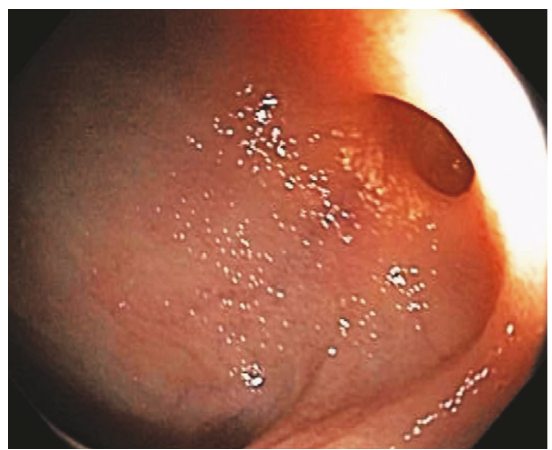
Figure 12: Endoscopic image of an uncommon ileal diverticulum (right upper corner) in the ileocecum.